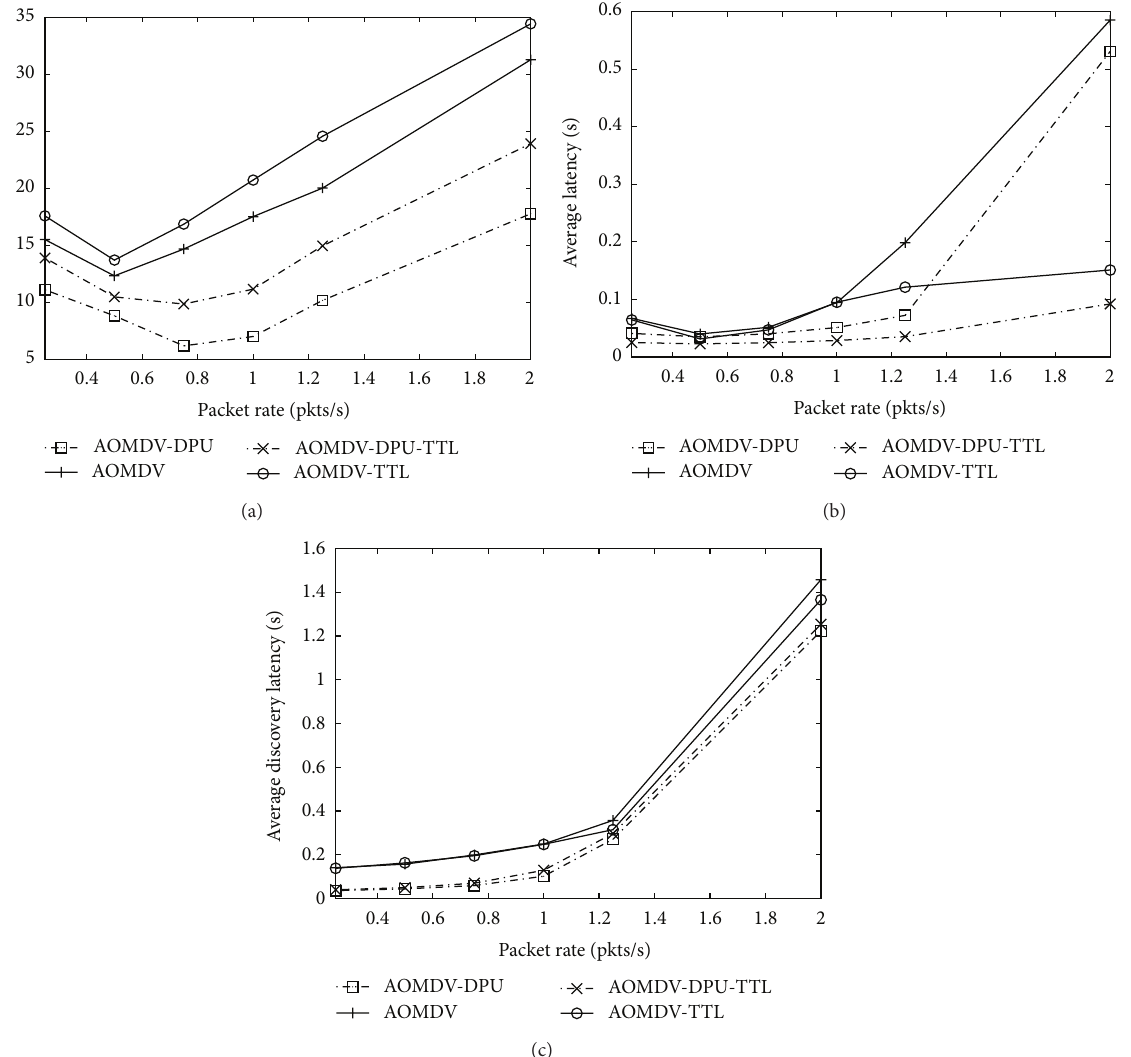
Figure 7: Performance with varying packet rate (a) packet loss, (b) average packet delivery latency, and (c) route discovery latency.